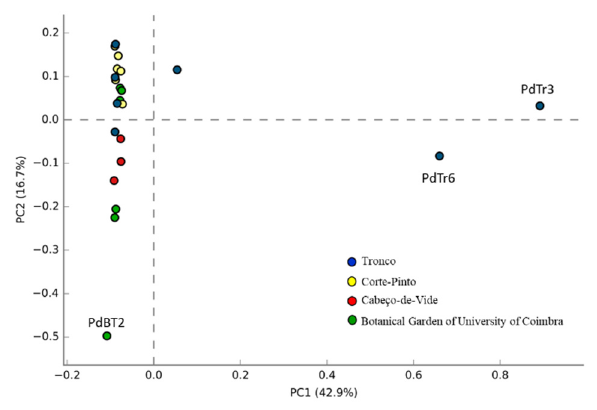
Figure 4. Principal component analysis of the bacteria present in Porcellio dilatatus gut samples, determined at the family level. P. dilatatus gut sampled from Tronco (PdTr) (blue); Corte-Pinto (PdCP) (yellow); Cabeço-de-Vide (PdCV) (red), and Botanical Garden of University of Coimbra (PdBT) (green). 59.6% of the variation was explained by the two principal components PC1 and PC2. 3.3. Presence of Endosymbionts and Parasites in Porcellio dilatatus Bacterial Communities The presence of Wolbachia sp., Rickettsiella spp. and Candidatus Hepatoplasma was observed in the vast majority of the P. dilatatus gut samples studied. Of the 22 isopods, only three collected at Cabeço-de-Vide were not infected by Wolbachia sp., ten were infected